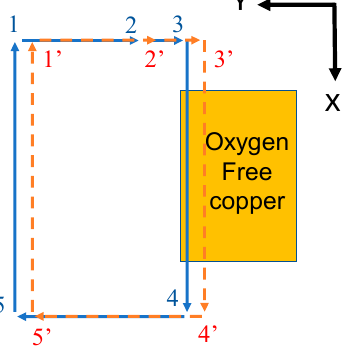
Figure 4. Planing cycle tool path diagram.